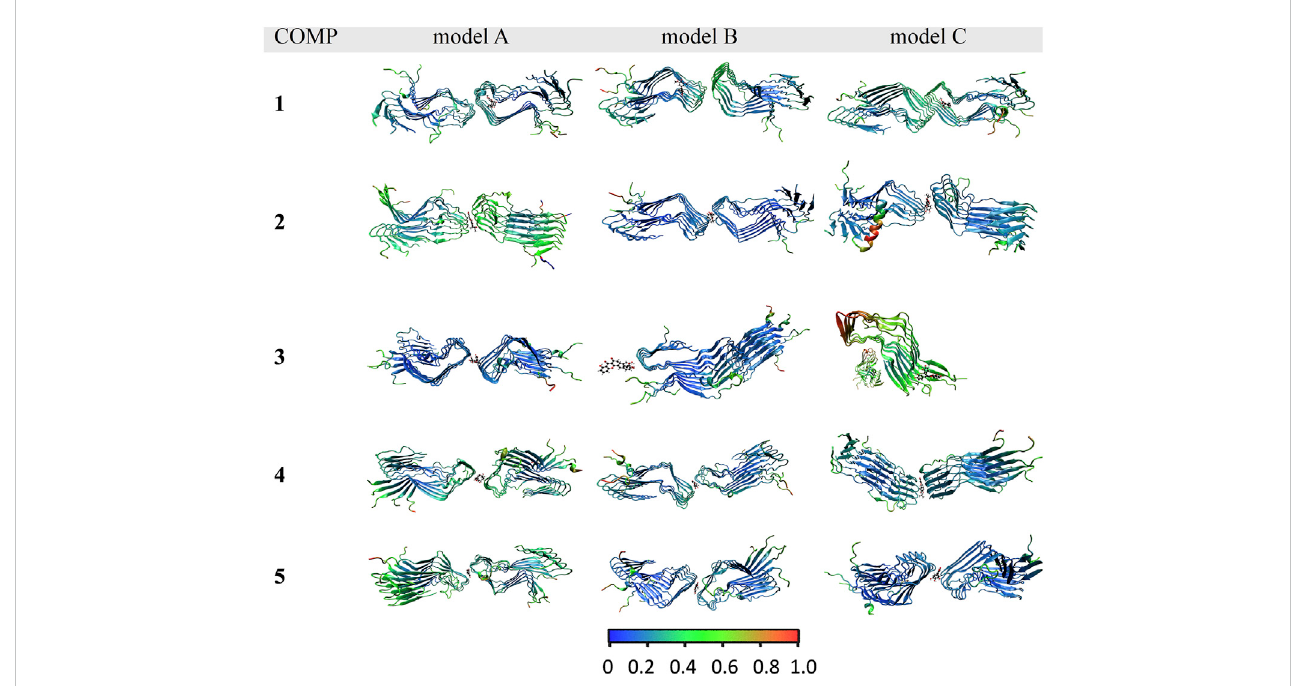
FIGURE 5 RMSF of COMP-fPrP 170 – 229 mapped onto the ribbon structure of fPrP 170 – 229